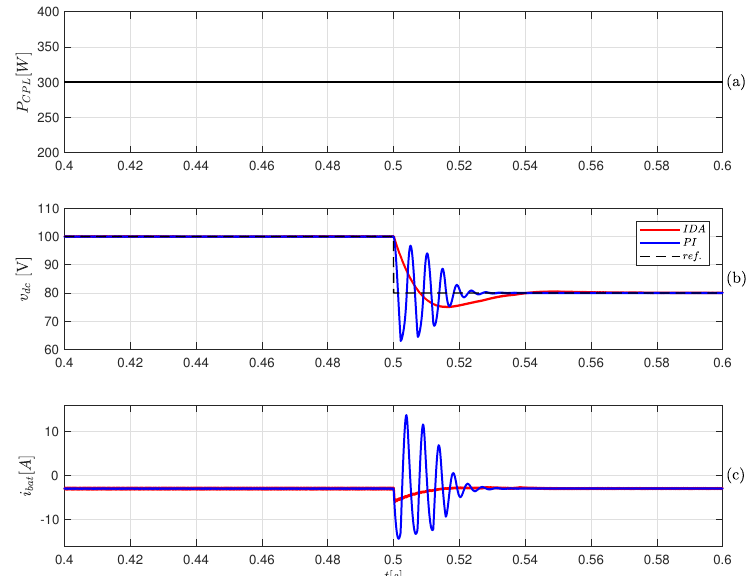
Figure 6. Performance of the MG for changes in v ∗